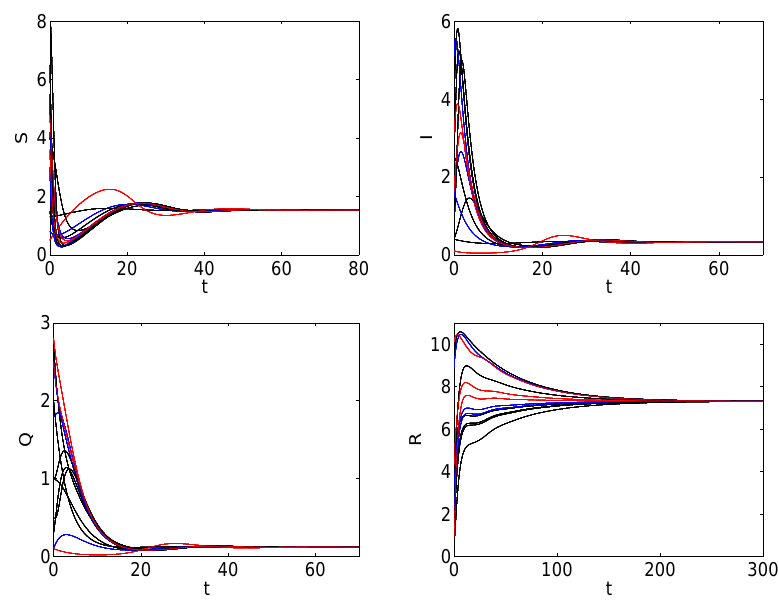
Figure 2. Variational curves of S , I , Q , and R with time t when R 0 = 2.4224 > 1.